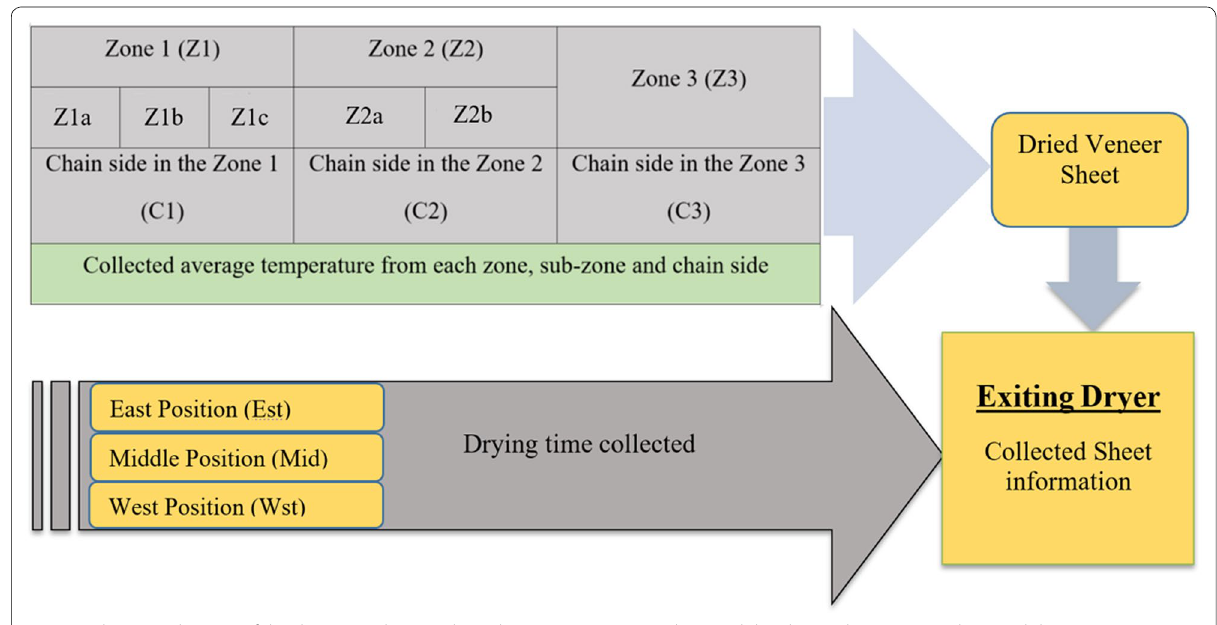
Fig. 1 Schematic diagram of the drying machine to show three zones (Z1, Z2 and Z3) and the chain sides (C1, C2 and C3) and dryer